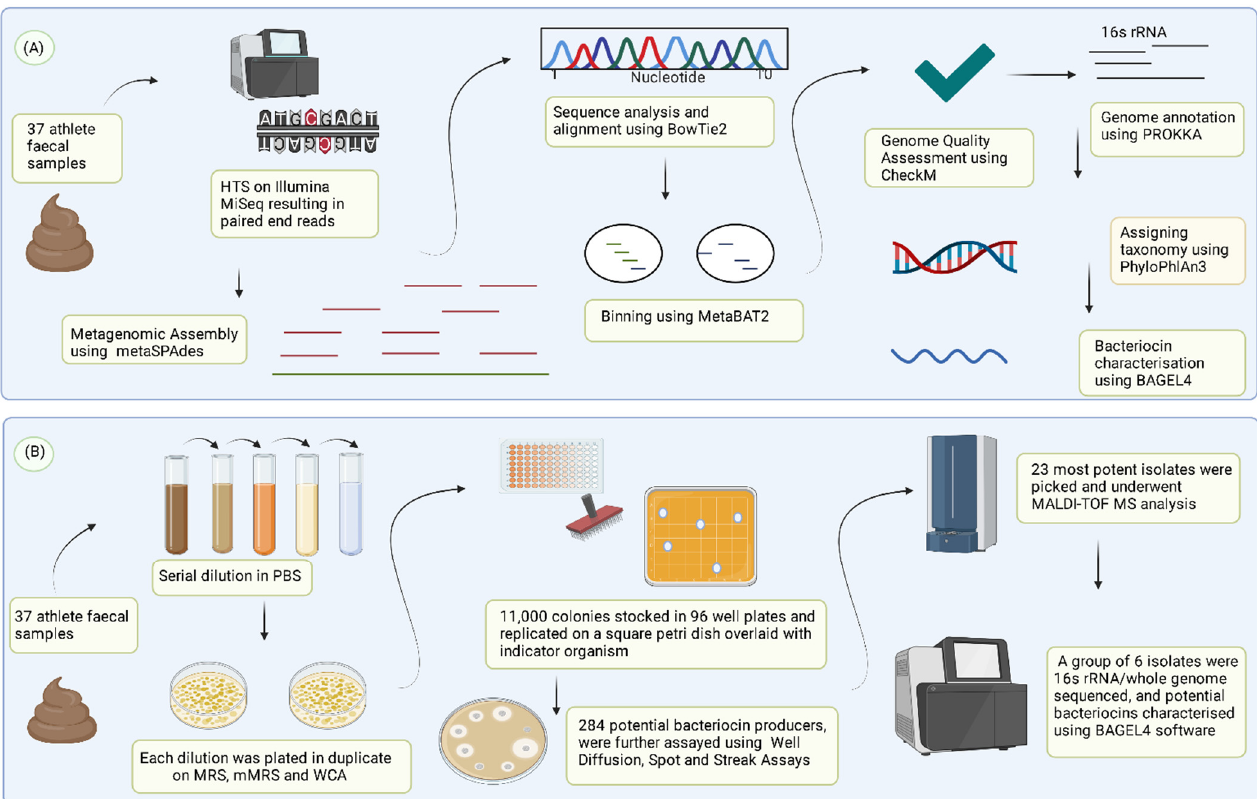
Figure 1. In silico and in vitro based approaches used in this study to identify potential novel bacteriocins from the athlete’s gut. ( A ) Metagenomic data from 37 faecal samples in the form of paired-end reads were assembled, annotated, quality-checked, and binned to recover Metagenome- Assembled Genomes (MAGS) analysed using BAGEL4 for the presence of potential bacteriocin genes. ( B ) 37 faecal samples from elite Irish athletes were screened for novel bacteriocin-producing gut isolates. Potential bacteriocin producers were assayed further, and the spectrum of inhibition was assessed. Isolates exhibiting potential antimicrobial activity were brought forward for MALDI- TOF mass spectrophotometry, whole-genome sequencing (WGS), and bacteriocin biosynthetic gene clusters were predicted using BAGEL4 software. (Figure created with https://BioRender.com, accessed 15 February 2022).